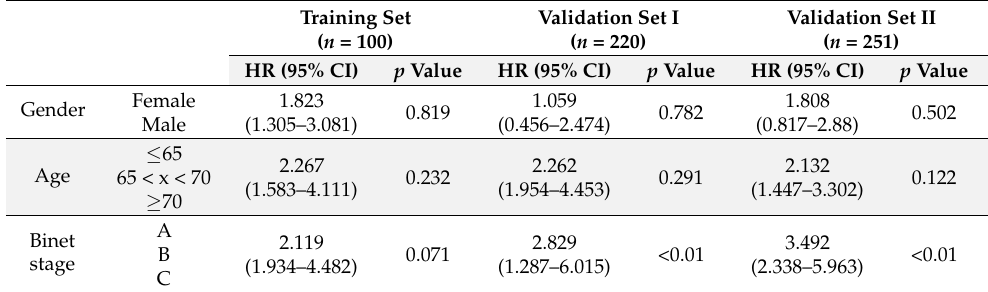
Table 4. Univariate Cox regression analysis of overall survival of the clinical variables in CLL patients.